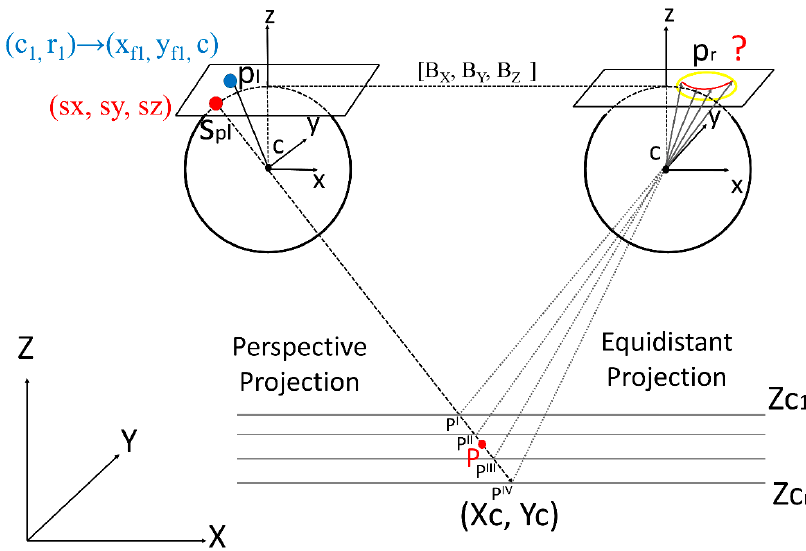
Figure 2. Epipolar line estimation using the proposed method, in which an image point in the left image (p l ) is projected to the object space (P I , P II ,…,P n ) using the inverse collinearity condition on the sphere domain, and re-projected to the right image (p r ) with the equidistant equations.